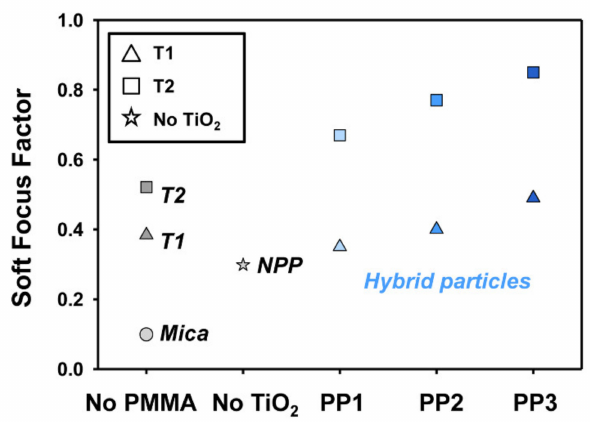
Figure 9. Soft-focus factor values of mica, T1, T2, NPP, and hybrid